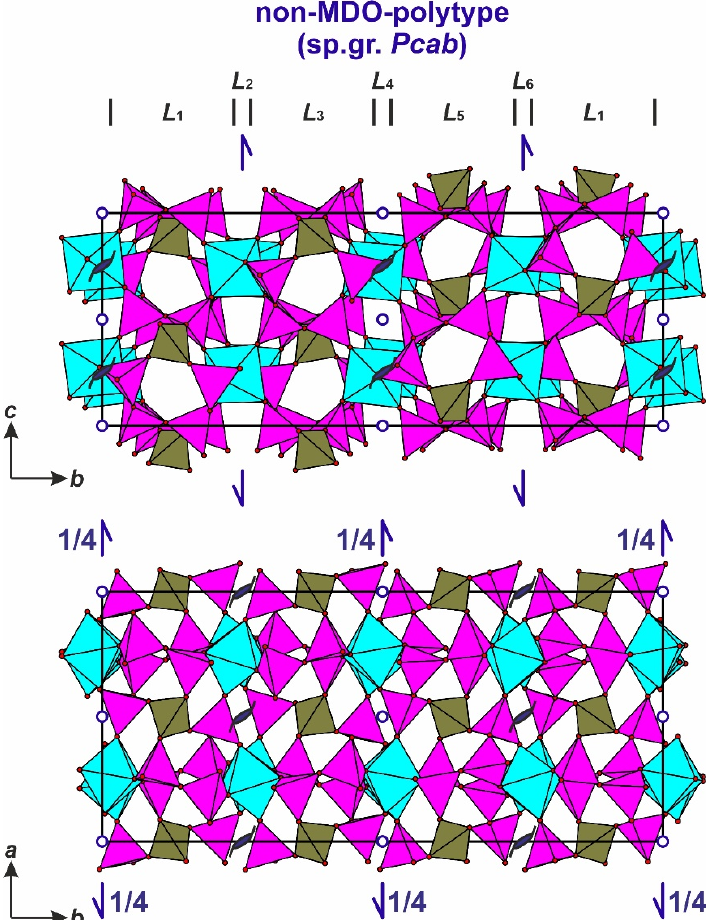
Figure 4. The general views of the non-MDO 4 O polytype. The operations active in the L 2 n type layers are shown. Modified after [20].